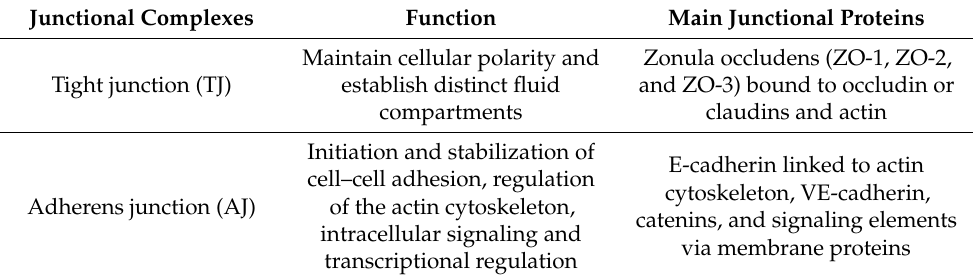
Table 2. Junctional